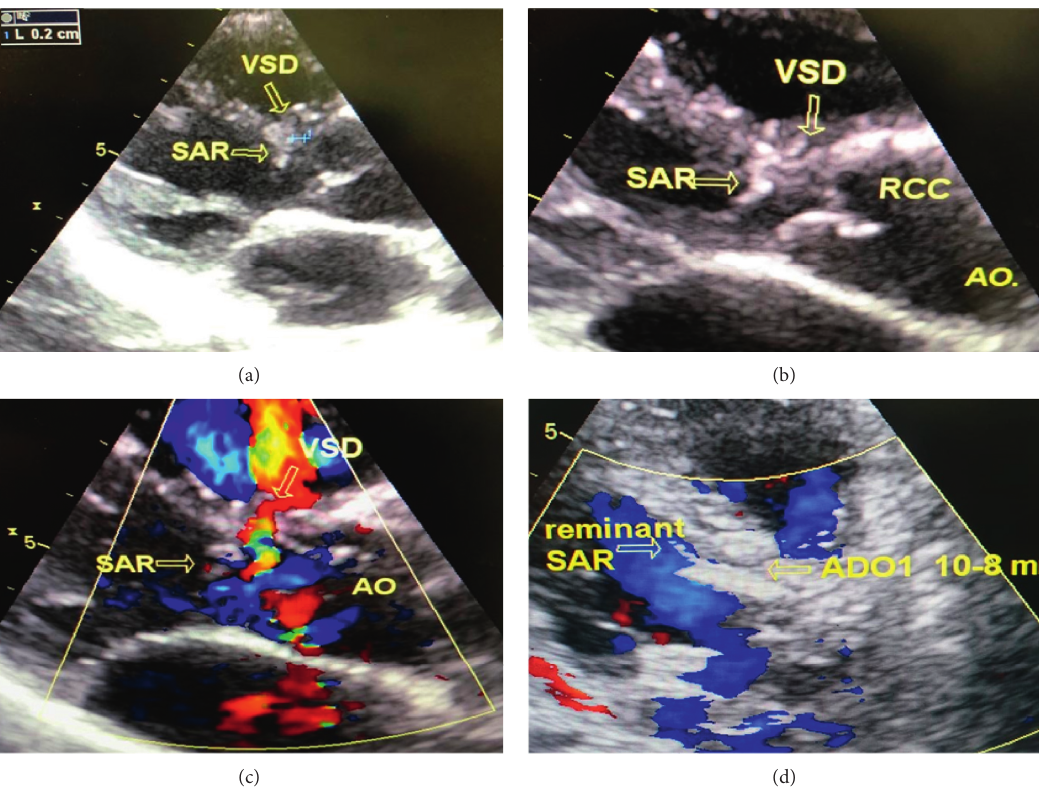
Figure 1: (a) and (b) Parasternal long axis 2D echocardiographic images of a 10-year-old female patient with a moderately sized per- imembranous subaortic VSD with mild prolapse of RCC and subaortic stenosis (fibromuscular ridge 2mm below the defect) with a systolic pressure gradient across the LVOTof 35mmHg. (c) Color flow imaging from the long axis parasternal view demonstrates the location of the defect with a left-to-right shunt and a long and thick subaortic ridge. (d) Modified parasternal long axis echocardiographic image with color flow mapping demonstrates ADO-I (10–8 mm) closing the defect and compressing the ridge against the IVS without residual shunt or AR. The peak systolic pressure gradient decreased to